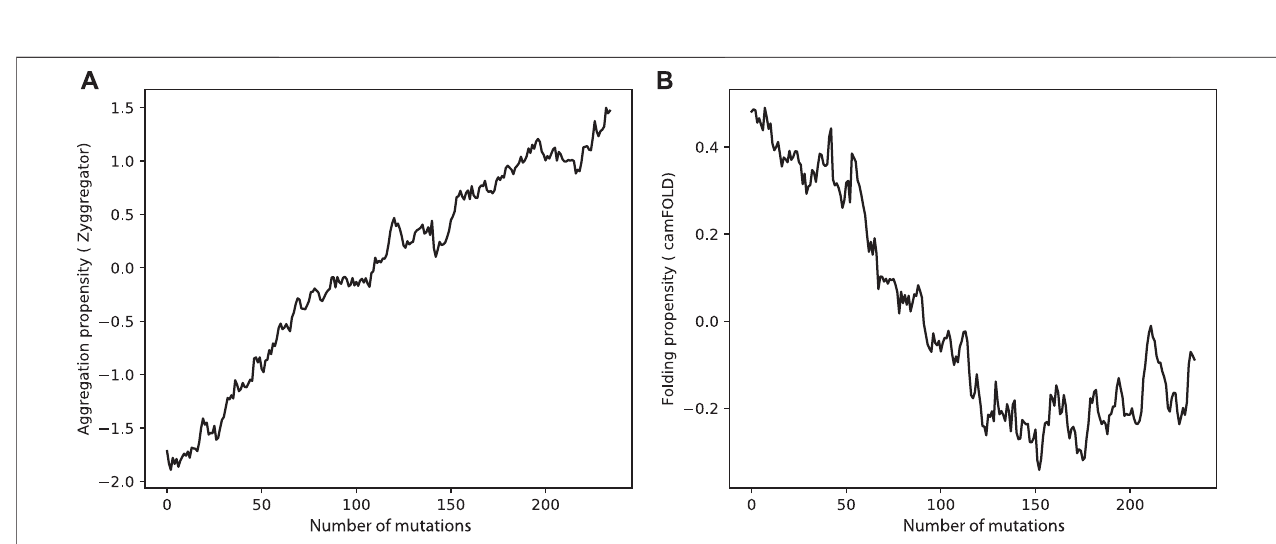
FIGURE 2 | Aggregation and folding propensities changes upon amino acid mutations in human proteome. (A) The aggregation propensity increase while the protein accumulate random mutations. By contrast, (B) the folding propensities decreases when the protein is subjected to mutation.